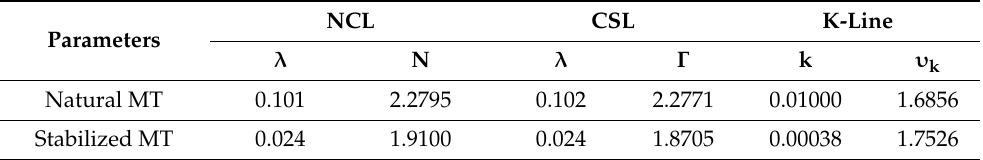
Table 6. Parameters of the critical states theory before and after stabilization.